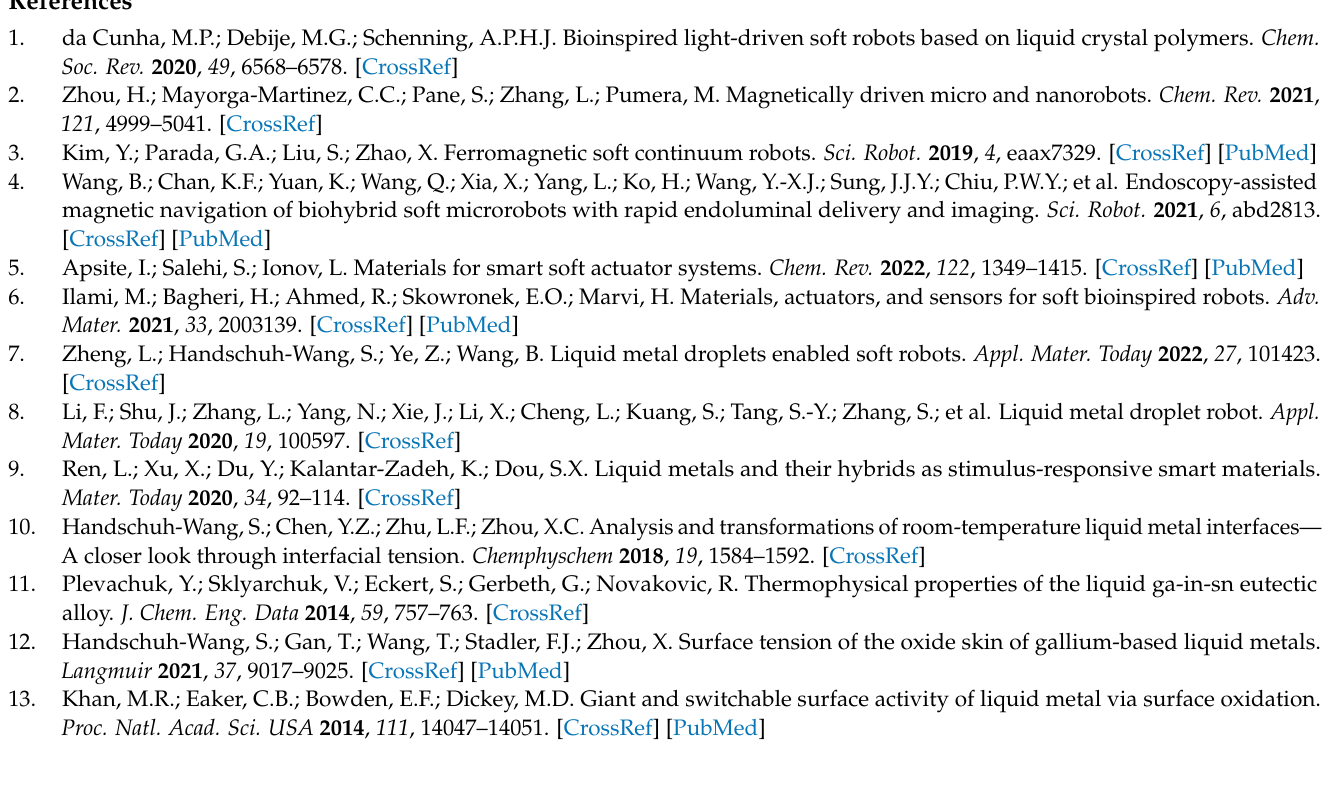
S4: gel fraction and swelling fraction of the Ga–PU composites; Figure S5: SEM micrographs of the Ga–PU composites; Figure S6: sheet resistance of the Ga–PU composite changing with storing time; Figure S7: DSC curve of PCL-diol; Figure S8: mechanical properties of the PU elastomer and Ga–PU composites; Figure S9: shape programming and shape recovery of the pure PU elastomer; Figure S10: mechanical properties of the pristine and healed PU elastomers; Video S1: shape recovery of the programmed Ga–PU composite; Video S2: a soft gripper grasping and transferring an object;